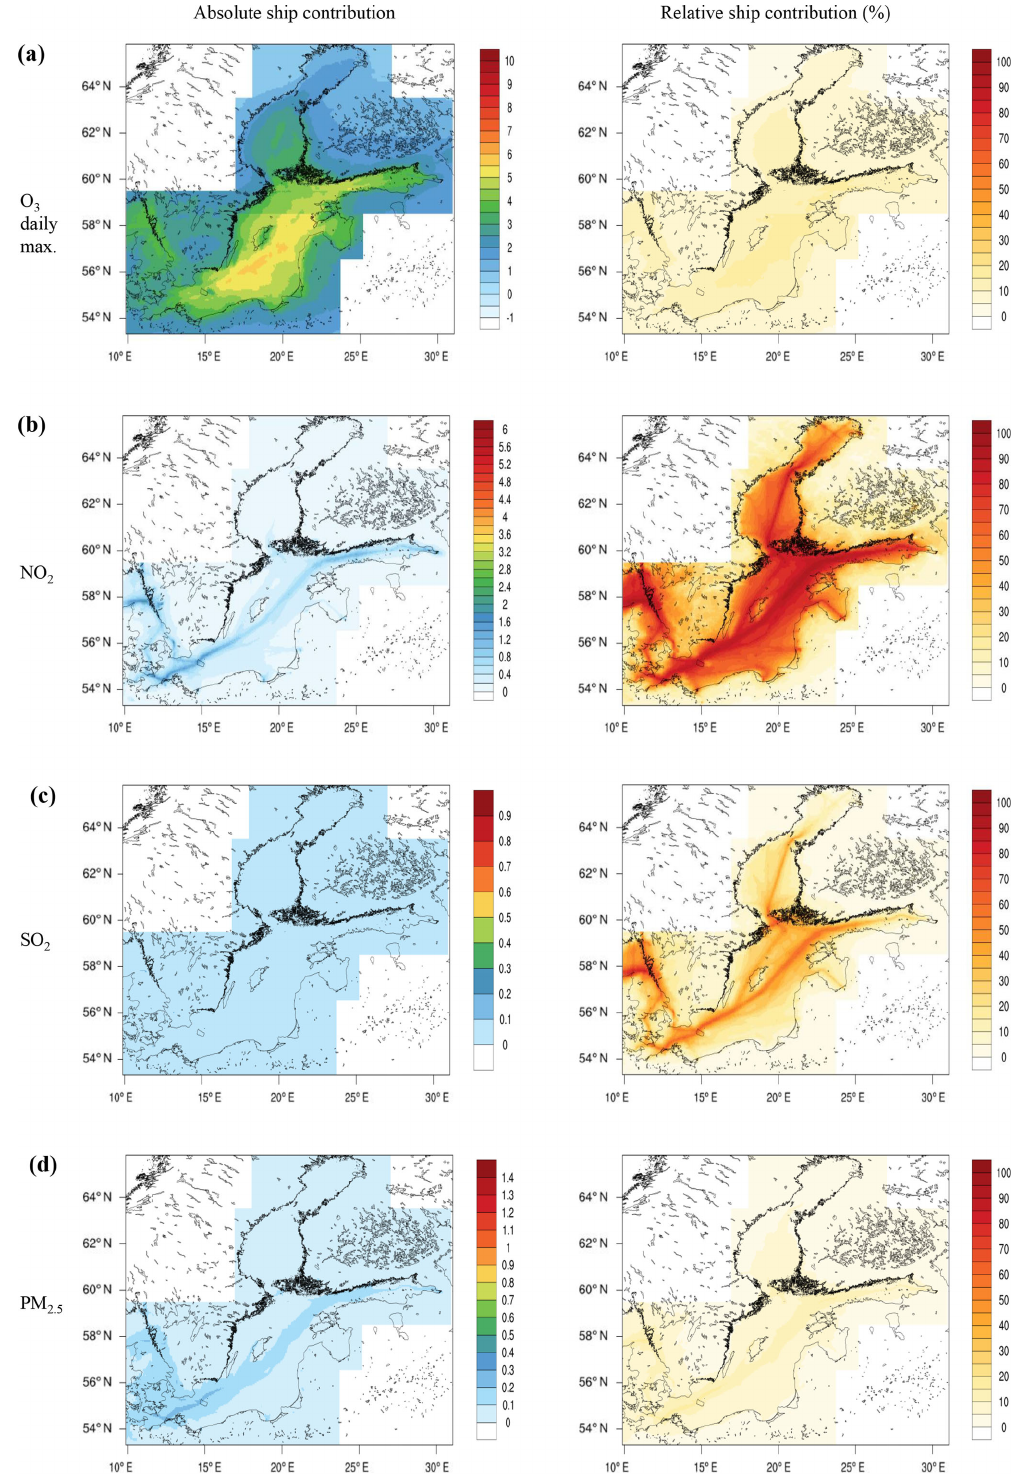
Figure 7. Future (2040) ship contribution in the Baltic Sea region in summer (JJA) from CMAQ model results for the BAU 2040 scenario: ship-related concentration (left) for gaseous pollutants (in ppbv) and for PM 2 . 5 (in µgm − 3 ), percentage ship contribution (right) for (a) daily maximum O 3 , (b) NO 2 , (c) SO 2 , and (d) PM 2 . 5 . Ship-related contribution only shown for the high-resolution area. The same scales as in Fig. 5 were used to facilitate comparison of the concentration and contribution maps. The sharp change in the O 3 ship contribution north of 58.8 ◦ N is an artefact of the averaging in the overlap area of the two 4km resolution